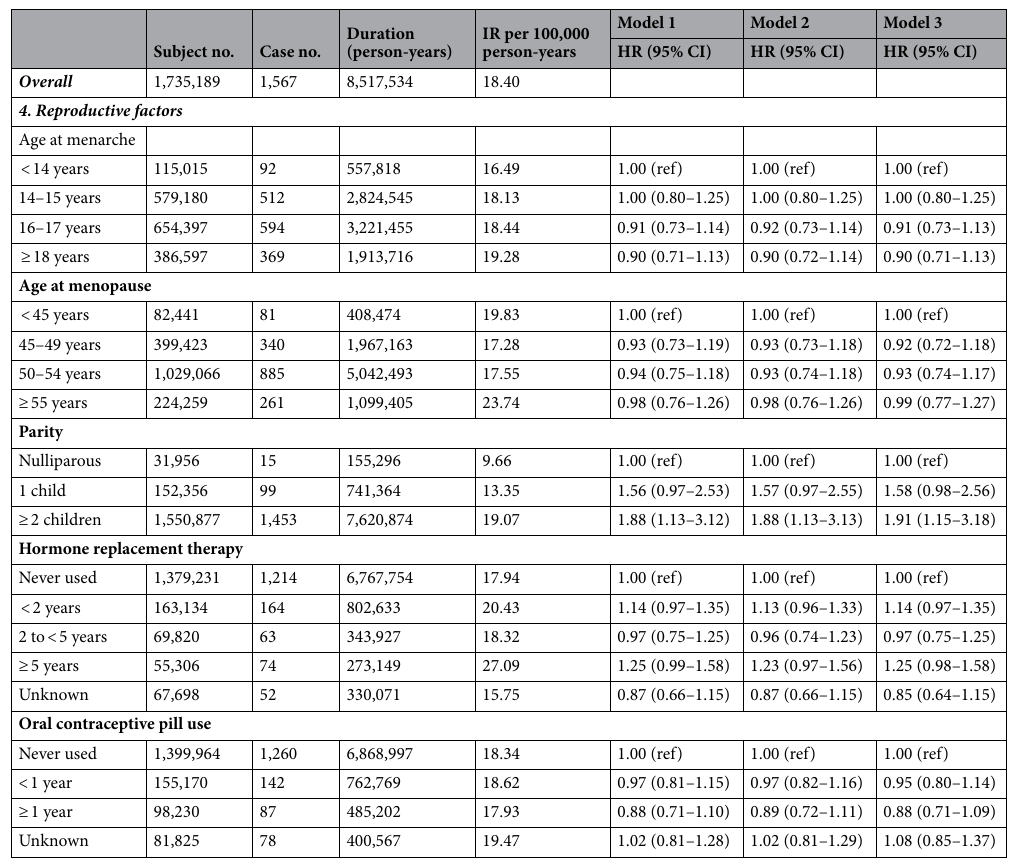
Table 5. Hazard ratios and 95% confidence intervals for the association between reproductive factors and the risk of idiopathic macular hole development in postmenopausal women. IR incidence rate, HR hazard ratio, CI confidence interval, Q quartile. Model 1: adjusted for age. Model 2: adjusted for demographic factors (age, income level), systemic comorbidities (hypertension, dyslipidemia, stroke, heart disease, chronic kidney disease), and behavioral factors (smoking history, drinking habit, physical activity, body mass index). Model 3: adjusted for demographic factors, systemic comorbidities, behavioral factors, and female reproductive factors (age at menarche, age at menopause, parity, hormone replacement therapy, oral contraceptive